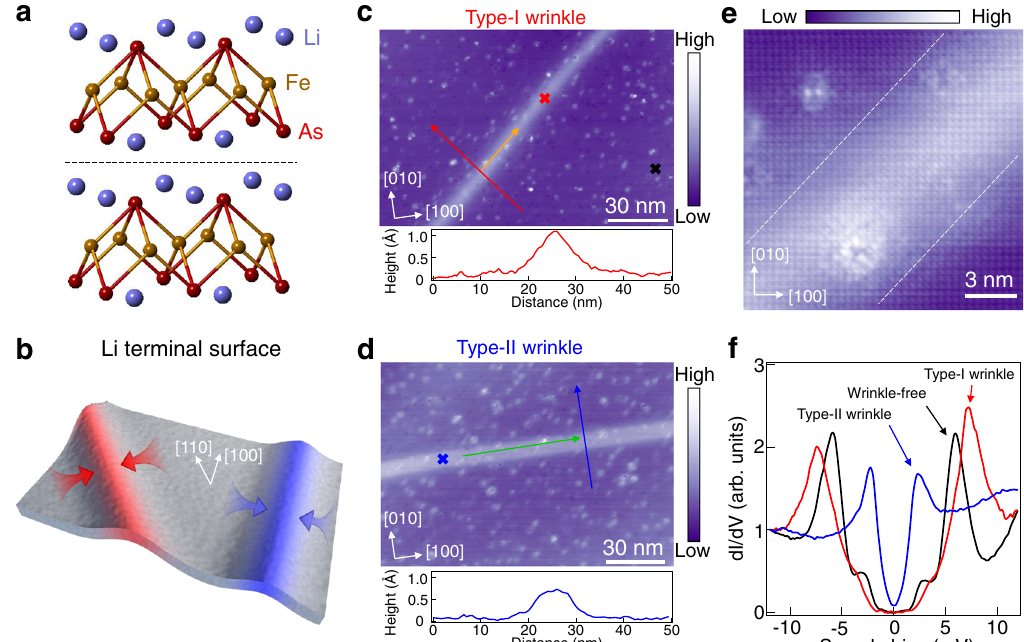
Fig. 1 Strain-induced wrinkles on LiFeAs surface. a The crystal structure of LiFeAs. The black dashed line indicates the location where the cleavage happens. b The sketches of the two types of wrinkles and the local strain on LiFeAs surface. c Upper panel: a large scale STM topography of LiFeAs surface showing a type-I wrinkle. The [100] and [010] mark the lattice directions on the Li terminal surface, respectively. Setpoint: V s = − 20 mV, I t = − 20 pA. Lower panel: a line pro fi le taken along the red line in the upper panel. d Upper panel: a large scale STM topography of LiFeAs surface showing a type-II wrinkle. Setpoint: V s = − 30 mV, I t = − 20 pA. Lower panel: a line pro fi le taken along the blue line in the upper panel. e The atomic resolution image of type- I wrinkle. The white dashed line indicates the wrinkle edge. Setpoint: V s = − 3 mV, I t = − 1 nA. f The d I /d V spectra taken at the three crosses in ( c and d ). Compared with the SC gaps ( Δ 1 = 5.8 meV, Δ 2 = 2.9 meV) detected at wrinkle-free region (black curve), two enlarged gaps ( Δ 1 = 7.3 meV, Δ 2 = 3.6 meV) is observed on type-I wrinkle (red curve), while a smaller gap (2.5 meV) is observed on type-II wrinkle (blue curve). Setpoint: V s = − 10 mV, I t = − 200 pA.